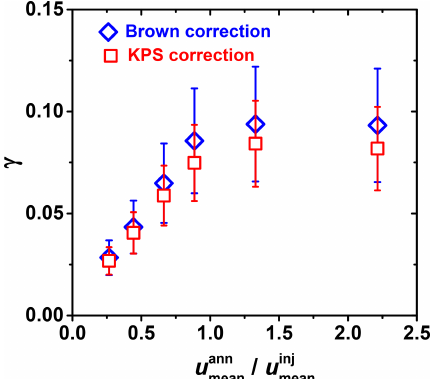
Figure A2. Differences in reactive uptake coefficient ( γ ) derived from two gas transport correction methods for fast heterogeneous kinetics involving OH uptake by glucose as a function of flow ve- locity ratio between mean gas flow velocity in the annular section of the flow reactor ( u ann mean ) and the gas flow exiting the movable in- jector ( u inj mean ). Red squares and blue diamonds represent the KPS and Brown methods,